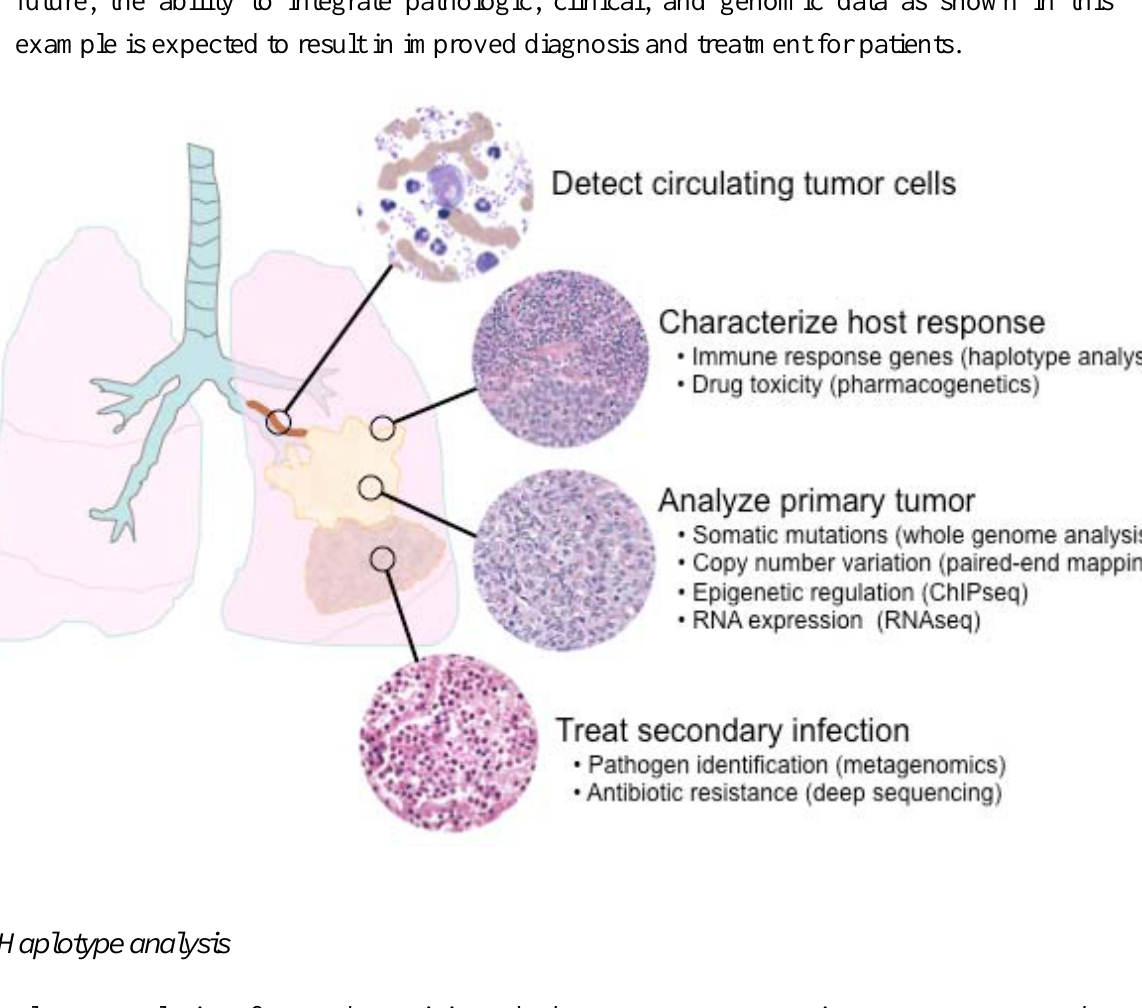
Figure 6. Possible applications of next-generation sequencing for clinical diagnostics.